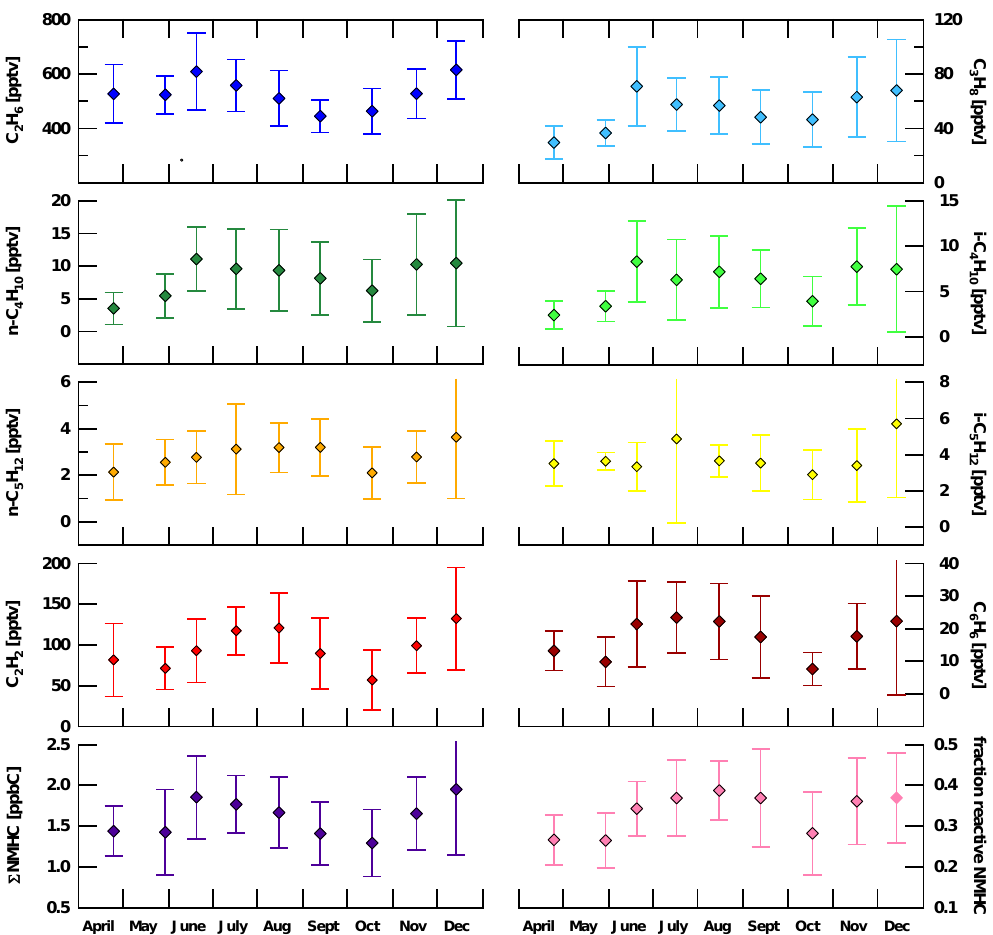
Fig. 3. Monthly mean mixing ratios of NMHCs from samples collected between 15 and 40 ◦ N along the FRA-MAA route. Error bars denote one standard deviation of the